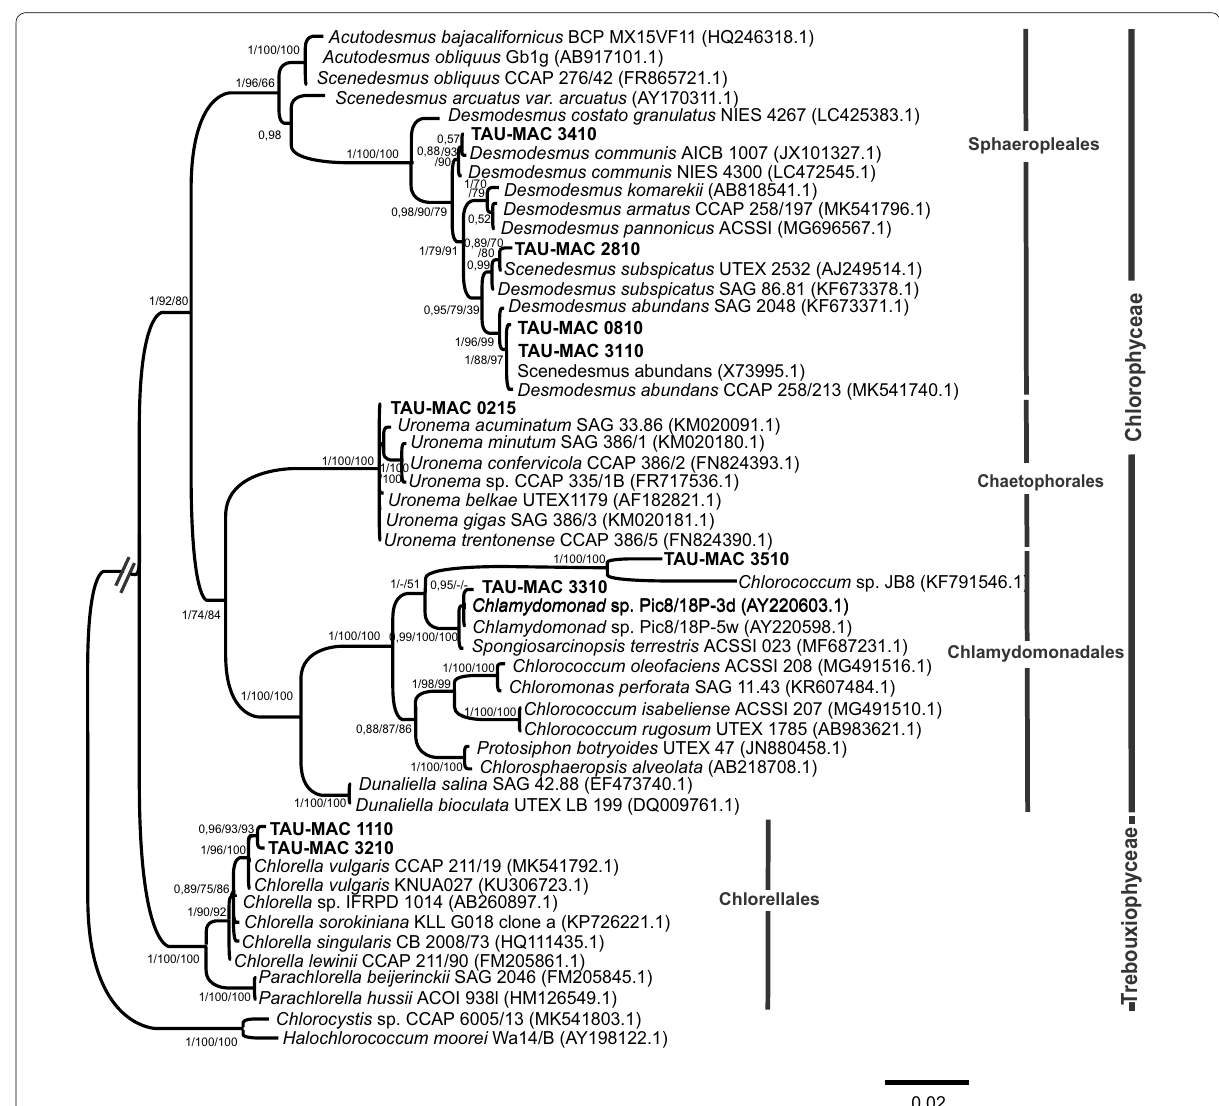
Fig. 3 Bayesian inference (BI) phylogenetic tree of relationships of 18S rRNA (c. 1700 bp) of green algae strains isolated from waterbodies of Greece, including the classes Chlorophyceae and Trebouxiophyceae. Support values are indicated as posterior probability for BI and bootstrap support for maximum likelihood (ML) and maximum parsimony (MP) analysis (BI/ML/MP). The numbers in parentheses are GenBank accession